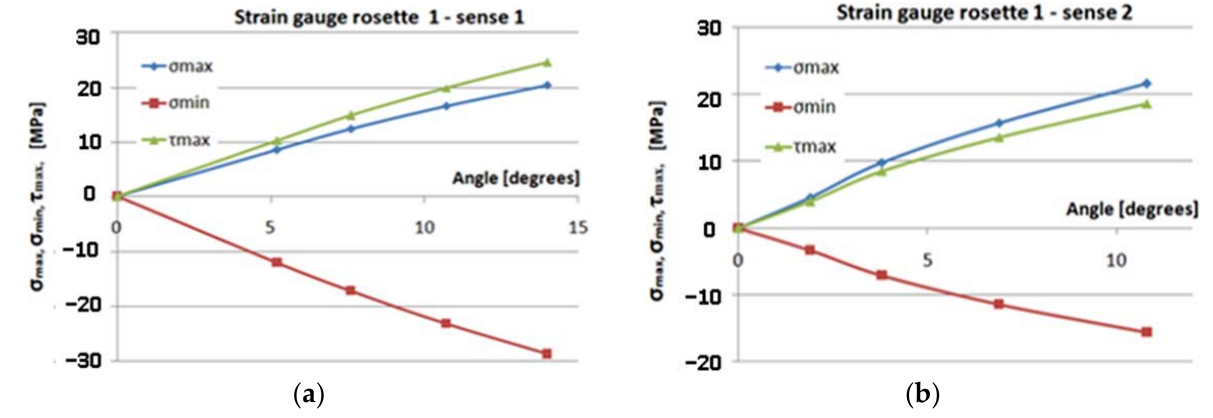
Figure 17. The variation of the maximum normal main stress σ max , σ min , and τ max , in relation to the angle of rotation. ( a ) Sense 1; ( b ) sense 2.